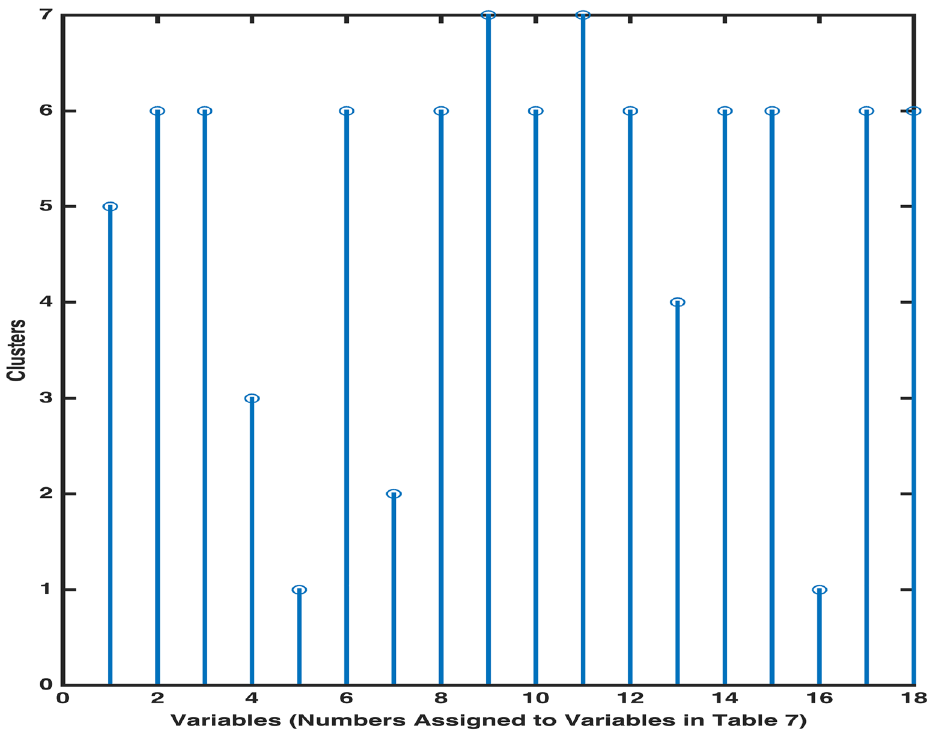
Figure 16. Stem diagram for clusters’ classification.